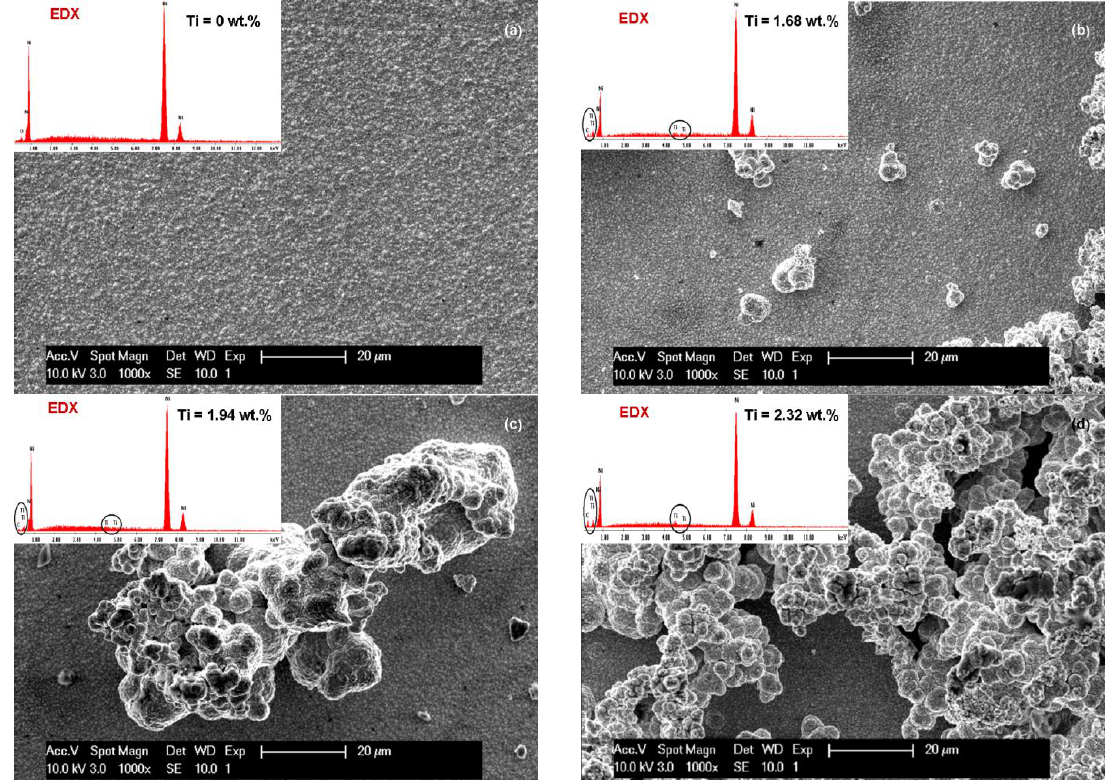
Figure 3. SEM surface morphology and EDX compozition for electrodeposited layers: ( a ) Ni/nano-TiC (0 g·L −1 ); ( b ) Ni/nano-TiC (10 g·L −1 ); ( c ) Ni/nano-TiC (15 g·L −1 ); and ( d ) Ni/nano-TiC (20 g·L −1 ) obtained at current density of 40 mA/cm 2 and deposition time of 15 min. The labelled element in EDX spectrum is titanium (Ti), which confirm the inclusion of TiC particles.